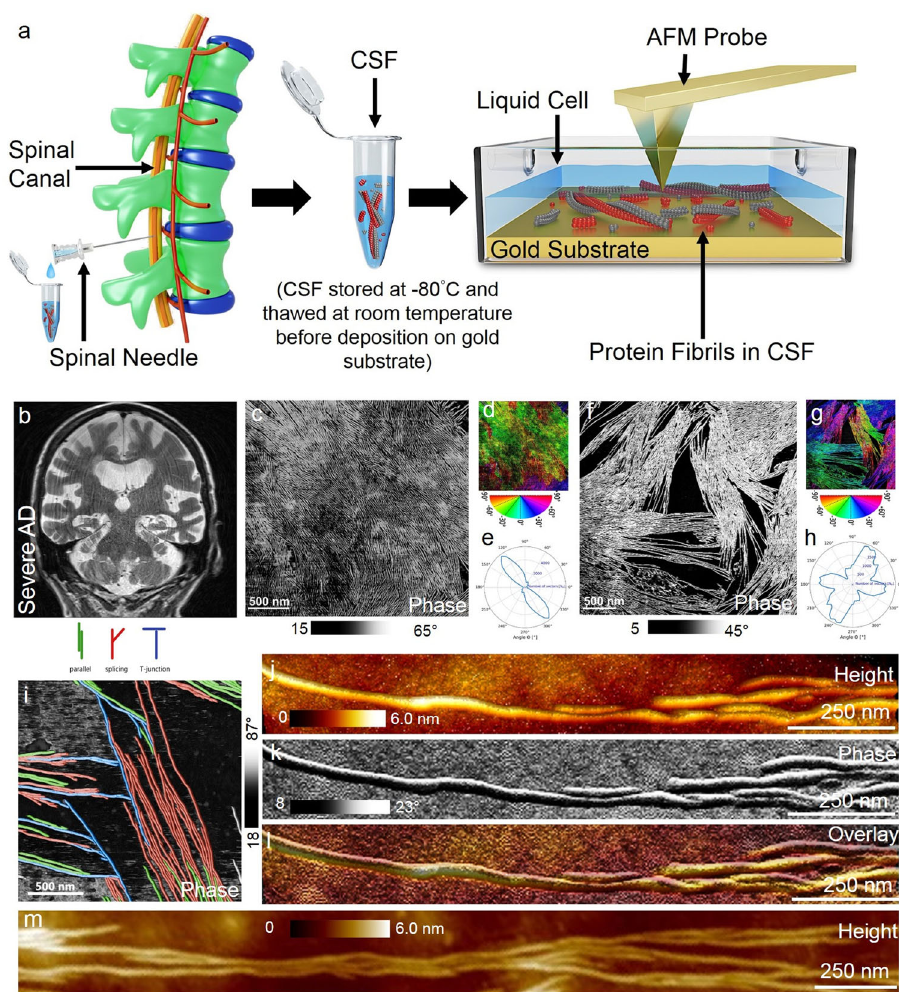
Fig. 1 Brain scan and AFM analysis of CSF from an individual with severe AD. a Schematic of the CSF extraction and deposition on a gold substrate placed within a liquid cell for AFM imaging under standard laboratory conditions (objects are not shown to scale). b A representative T1-weighted coronar MRI scan from patient KSSG:38 showed severe global brain atrophy (global cortical atrophy (GCA) scale 2) with a predominant temporal atrophy pattern (medial temporal atrophy (MTA) index 3-4). c Large-area phase-contrast AFM image showing fi brils in CSF from patient KSSG:38 arranged in a 2D format. d Colour-coded orientation distribution of the fi brils for the phase-contrast AFM image is shown in b and the corresponding polar plot distribution of the angles ( e ). f Large-area phase contrast image of fi brillar protein aggregates in a closely packed arrangement and the corresponding distribution in angles is shown in colour-coded phase image ( g ) and polar plot ( h ). i Phase-contrast AFM image showing sparsely arranged protein fi brillar aggregates in either parallel (green colour code), spliced (red colour code) or in T-junction (blue colour code) format. j – l High-resolution AFM height, phase and overlayed images showing well-resolved individual fi brils detected in the CSF from patient KSSG:38. m AFM height map of the ultralong single fi